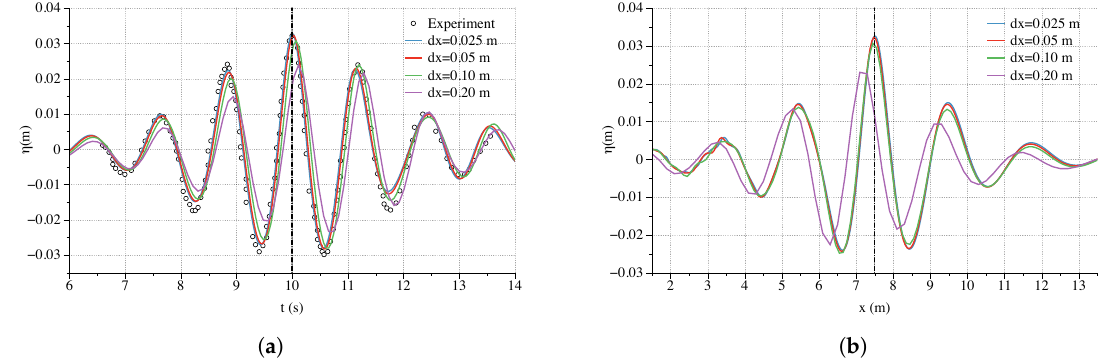
Figure 9. Grid convergence study in the x-direction for the case NING1, where four grid sizes are tested dx = 0.025, 0.05, 0.1 and 0.2 m. Ten vertical cells are used in the study. ( a ) The time series at the focusing location x = 7.5 m, ( b ) the spatial wave profiles at the focusing time t = 10.0